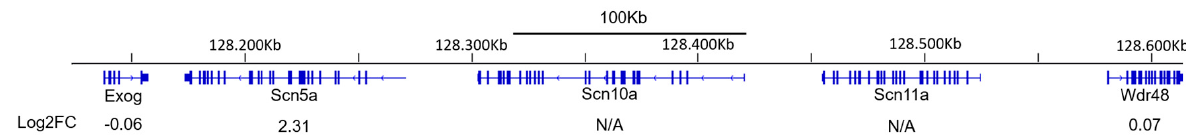
Figure 4. Scn5a is the only gene upregulated within the topological associated domain (TAD) . Limits of the TAD in which